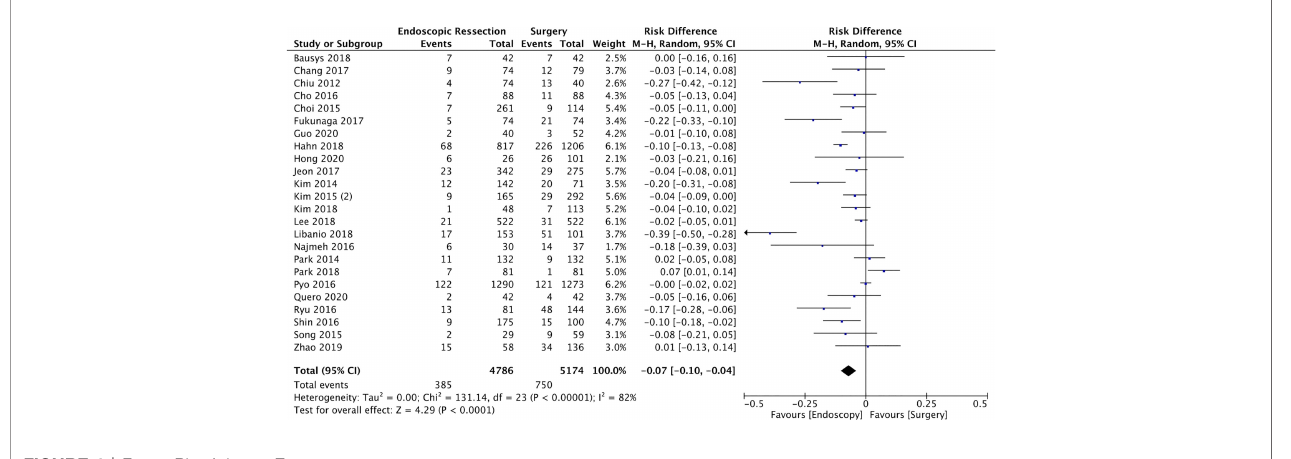
FIGURE 4 | Forest Plot Adverse Events.